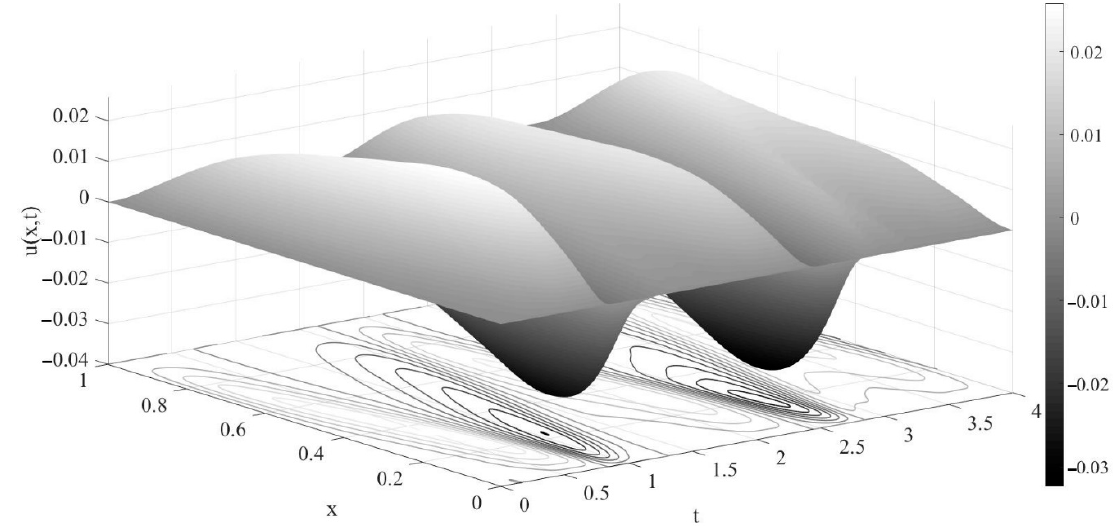
Figure 3. A graph of the approximate solution u ( 7 ) ( x , t ) of problems (1)–(4) under the imposed conditions in Example 2.